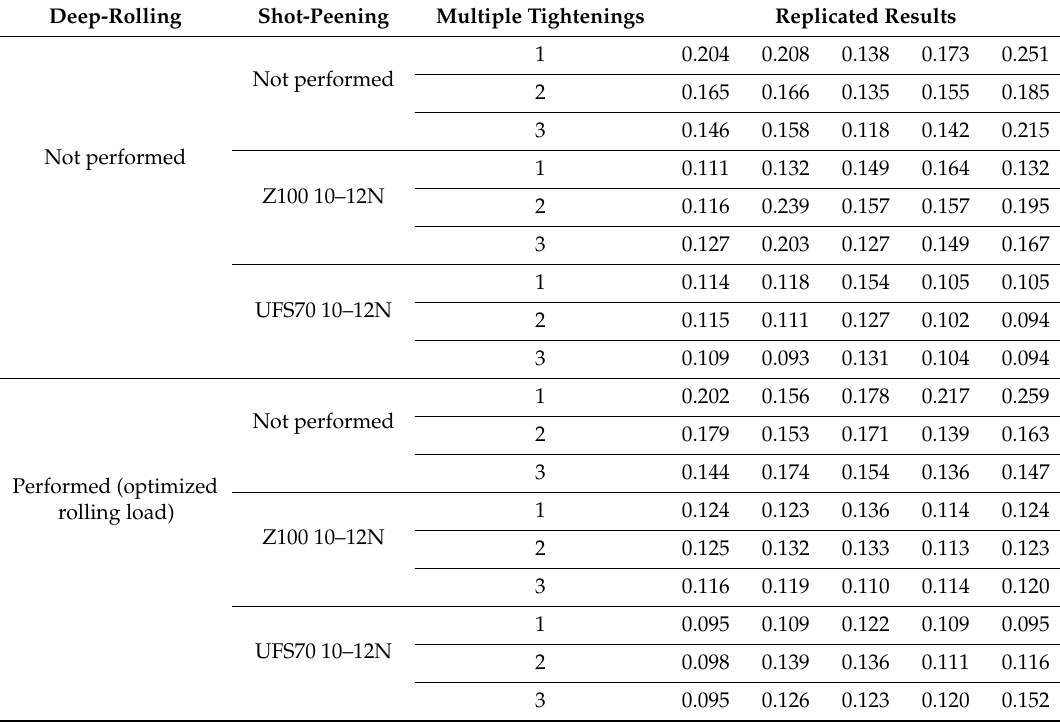
Table 5. Results in terms of bearing friction coe ffi cients ( µ b ) in grease lubricated conditions. Deep-Rolling